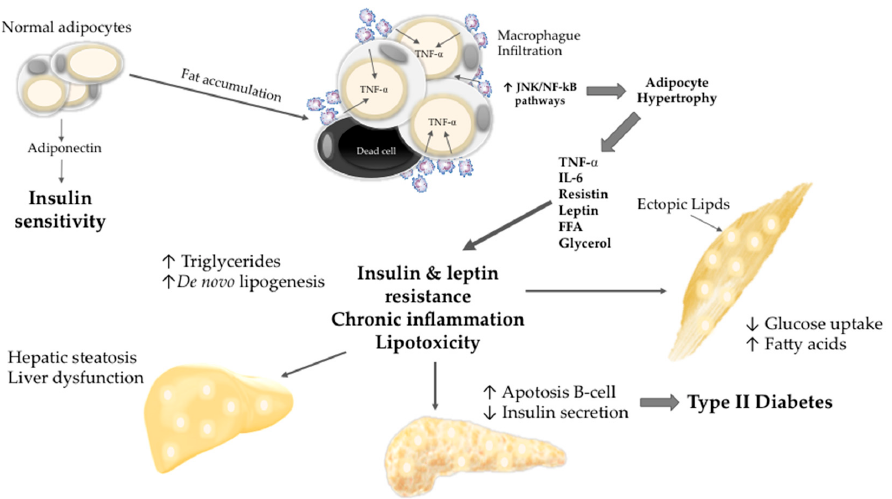
Figure 1. Adipocyte hypertrophy and systemic alterations. Adipocyte hypertrophy leads to chronic inflammation, insulin resistance (IR), and lipotoxicity. The increased flux of free fatty acid (FFA) to nonadipose tissues results in lipid accumulation, lipoapoptosis, and organ dysfunction.